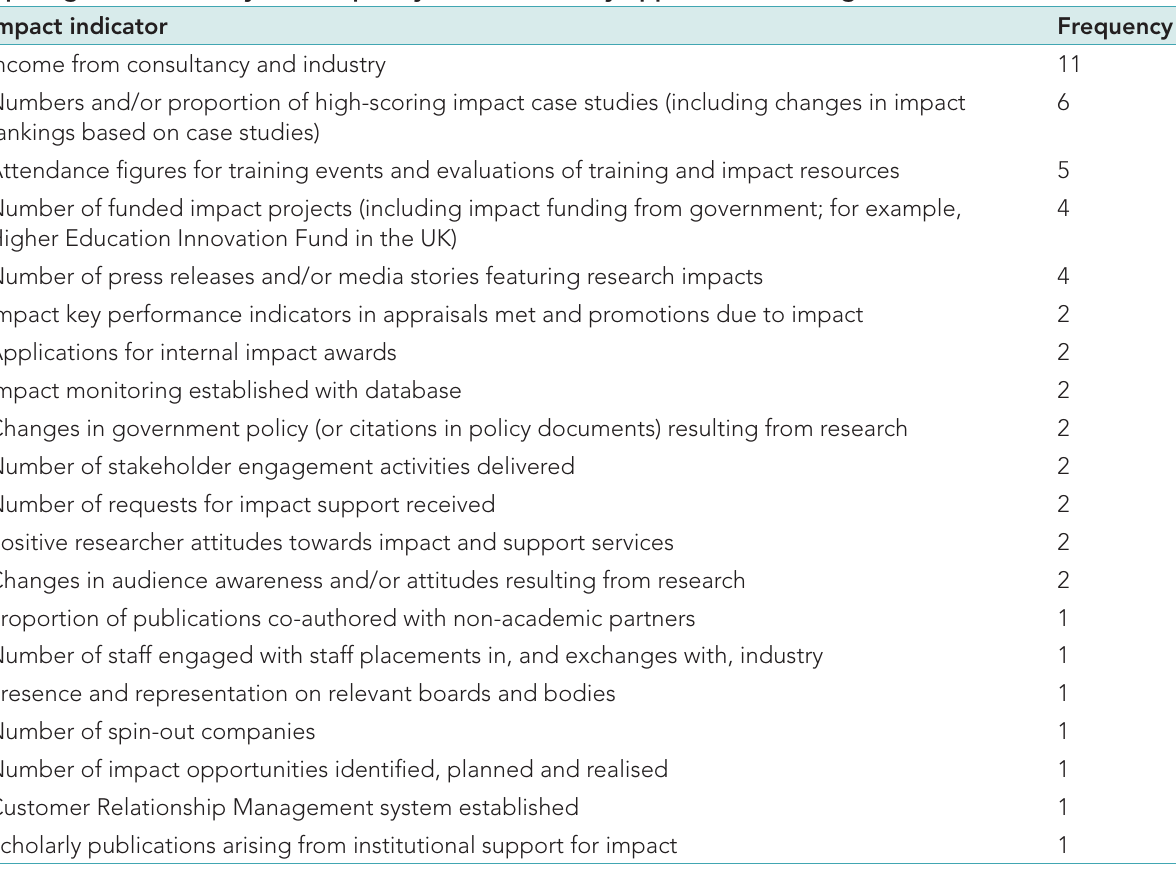
Table 2. Key performance indicators and success measures used to track progress towards strategic impact goals, ranked by the frequency with which they appeared in strategies (Source: Authors, 2022) Impact